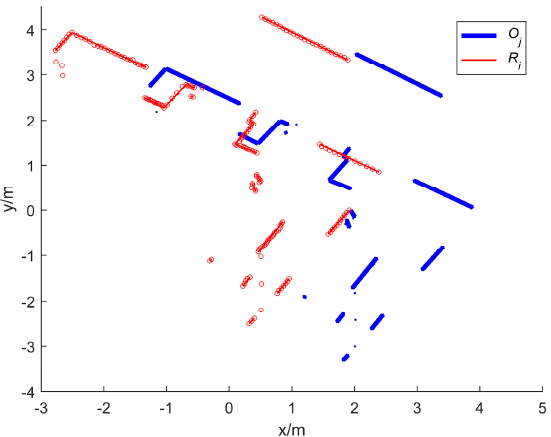
Figure 7. Distribution of straight-line segments of the data set after rotation.